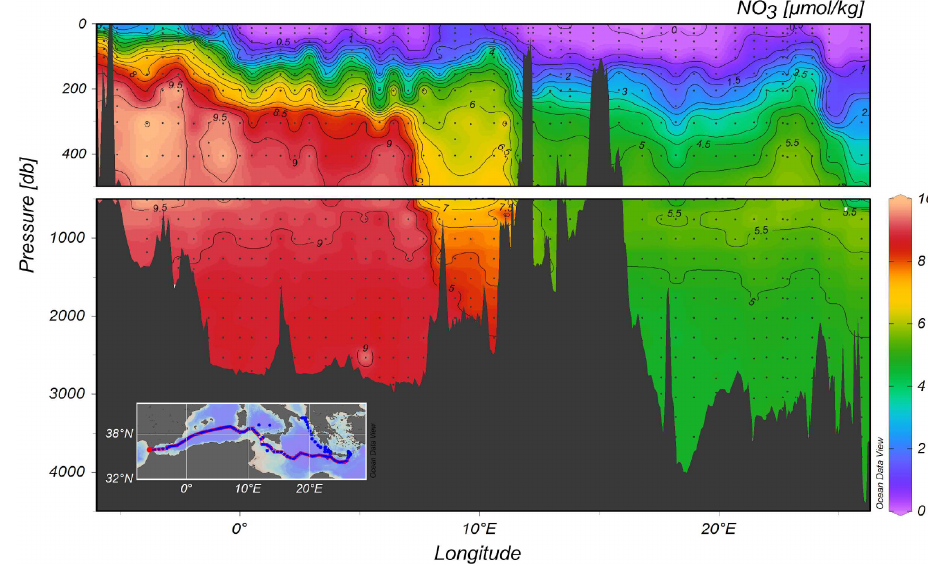
Figure 6. Distribution of nitrate along the trans-Mediterranean section.